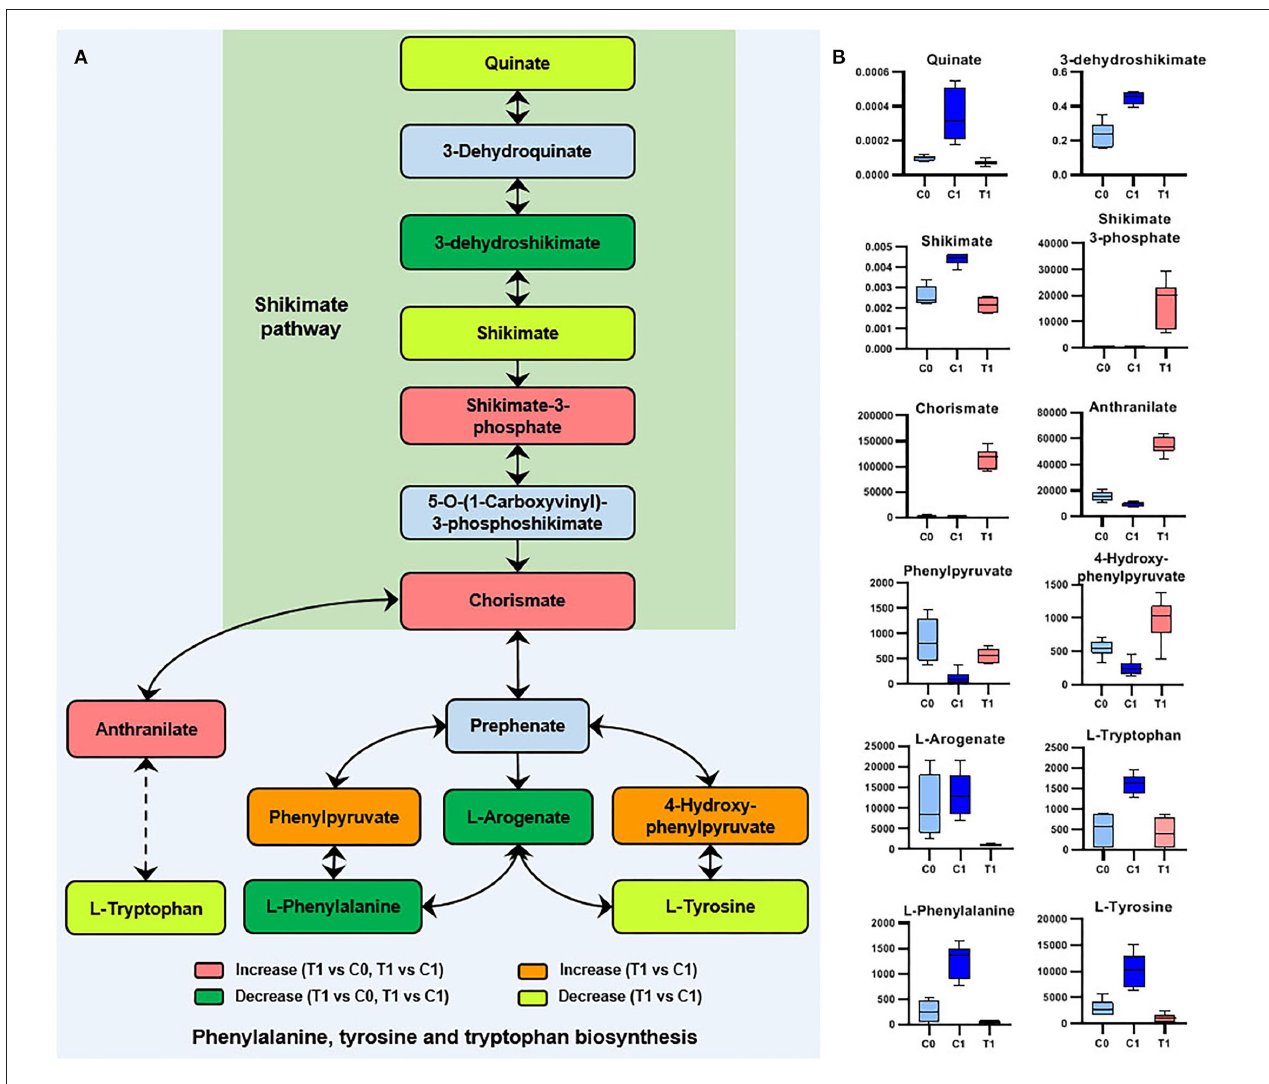
FIGURE 5 | Significant metabolites involved in phenylalanine, tyrosine, and tryptophan biosynthesis. (A) Relationship among metabolites. T1: BBR-exposed group; C0: initial control group; C1: growth control group. (B) Box plots for metabolites marked in A (|log2FC| > 1; P < 0.05; adj. P -value <